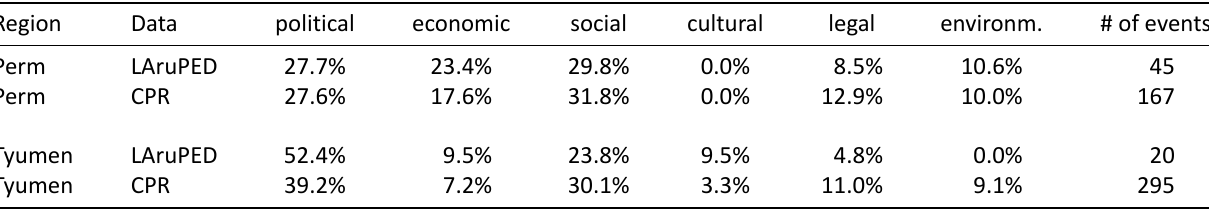
Table 4. Topics of protest as a share of all, by region and data source. Region